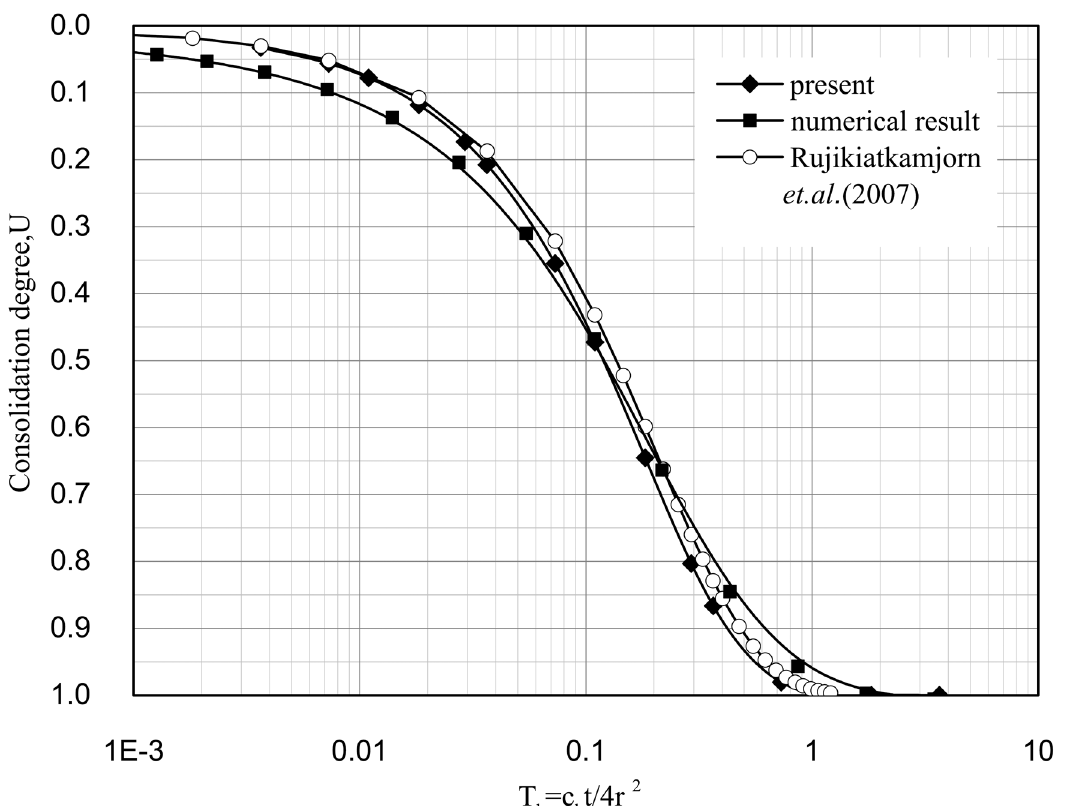
Fig 3. Solutions of Rujikiatkamjorn et al.[11], the present model, and the numerical